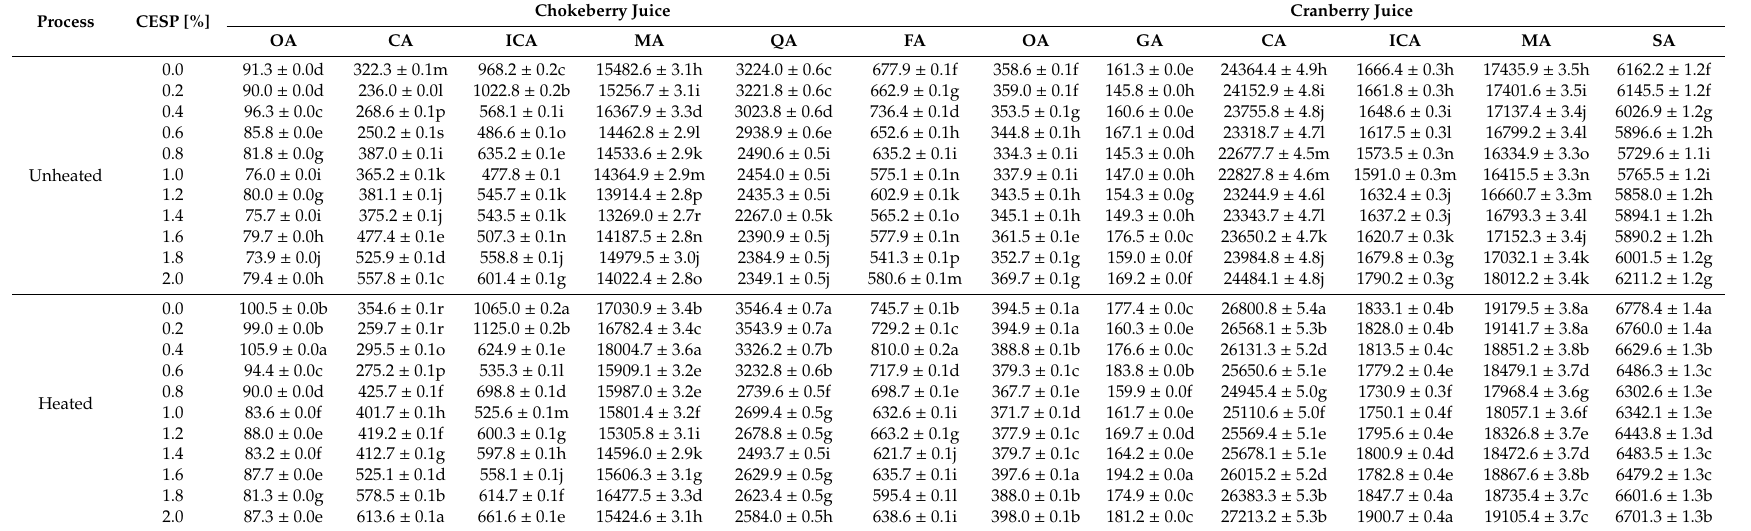
Table 2. The change of organic acid in the products before and after thermal